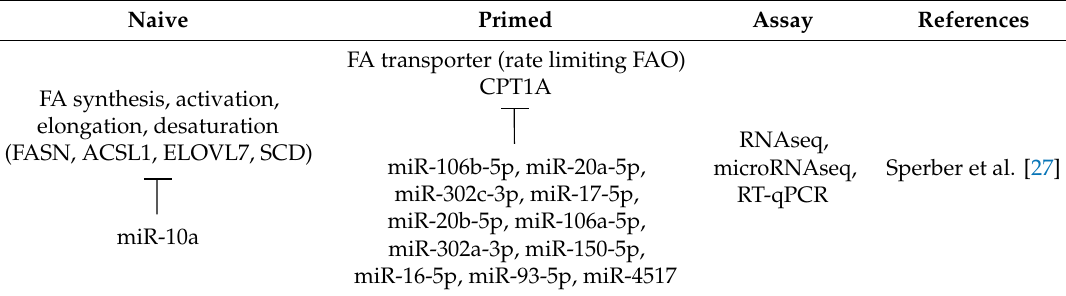
Table 3. Hypothetic role of microRNAs in regulation of fatty acid metabolism of naïve and primed embryonic stem cells (ESC).